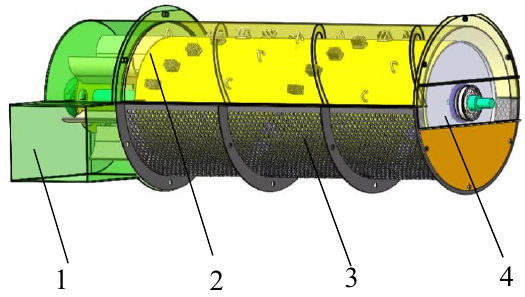
Figure 11. The 3D structure of the separation devices. 1. Impurity removal mechanism; 2. Cap; 3. Concave board for separation; 4. Separation drum.